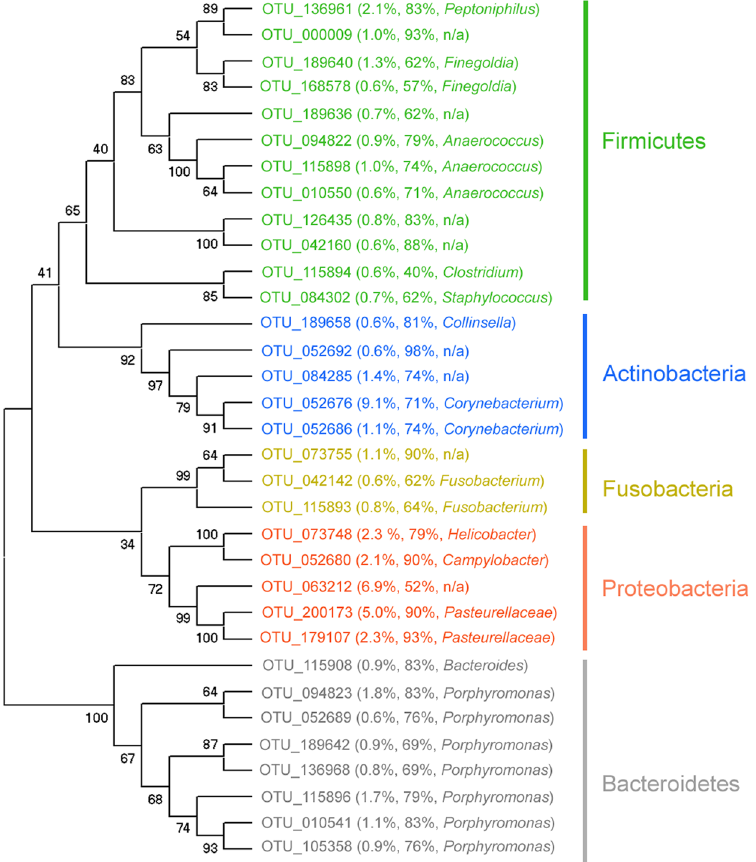
Figure 4. Neighbour-joining bootstrap consensus tree of the most common operational taxonomic unit (OTU) of bacteria associated with meerkat anal-pouch mixtures. The average percent abundance of all OTUs listed was > 0.5%. For each of the OTUs, the respective information in parentheses indicates the average percent abundance of the OTU among the paste samples, the percentage of samples in which the OTU was found and, if applicable, the genus to which the OTU was assigned. The numbers represent the percentage of 1000 replicates (bootstrap support) for which the same branching patterns were